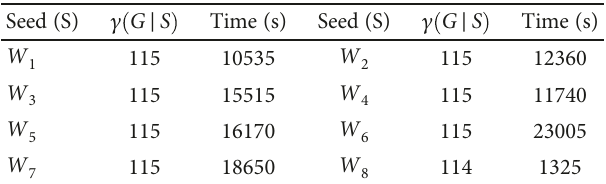
Table 2: The results for extending seeds from S .